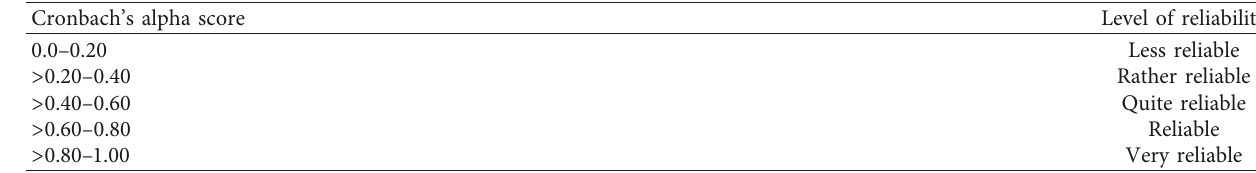
Table 2: Interpretation of Cronbach’s Alpha reliability statistics.